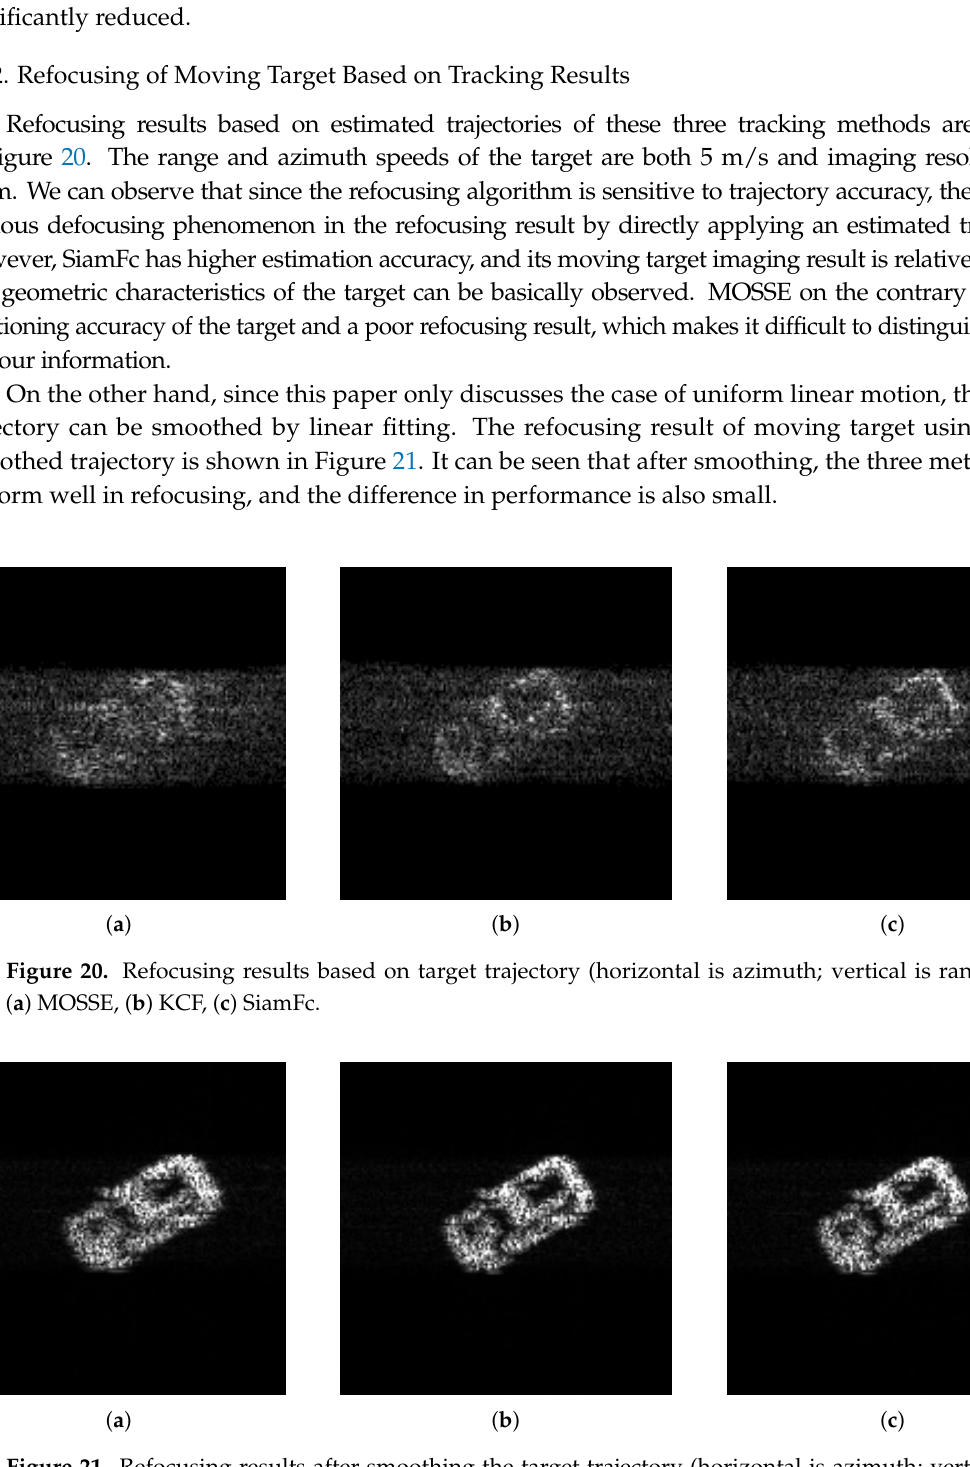
Figure 21. Refocusing results after smoothing the target trajectory (horizontal is azimuth; vertical is range). ( a ) MOSSE, ( b ) KCF, ( c )